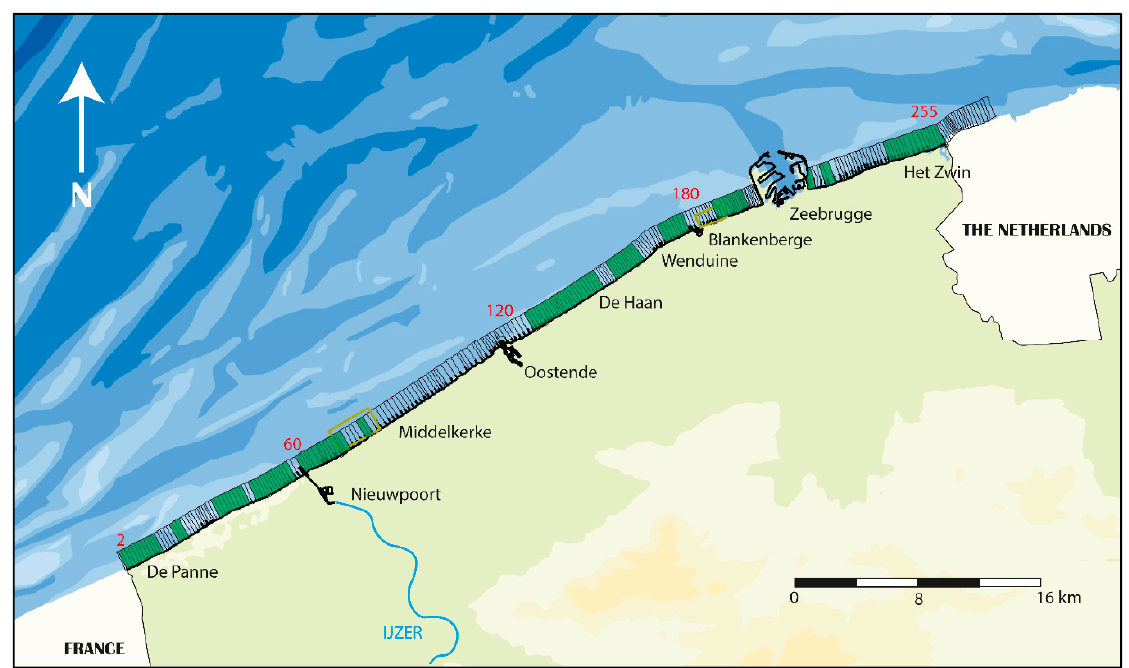
Figure 1. The 65 km long Belgian coast is located at the North Sea, between the French and the Dutch border and is divided into 254 coastal sections. The river ‘IJzer’ flows into the North Sea at Nieuwpoort. The green areas indicate the locations with vegetated coastal dunes.